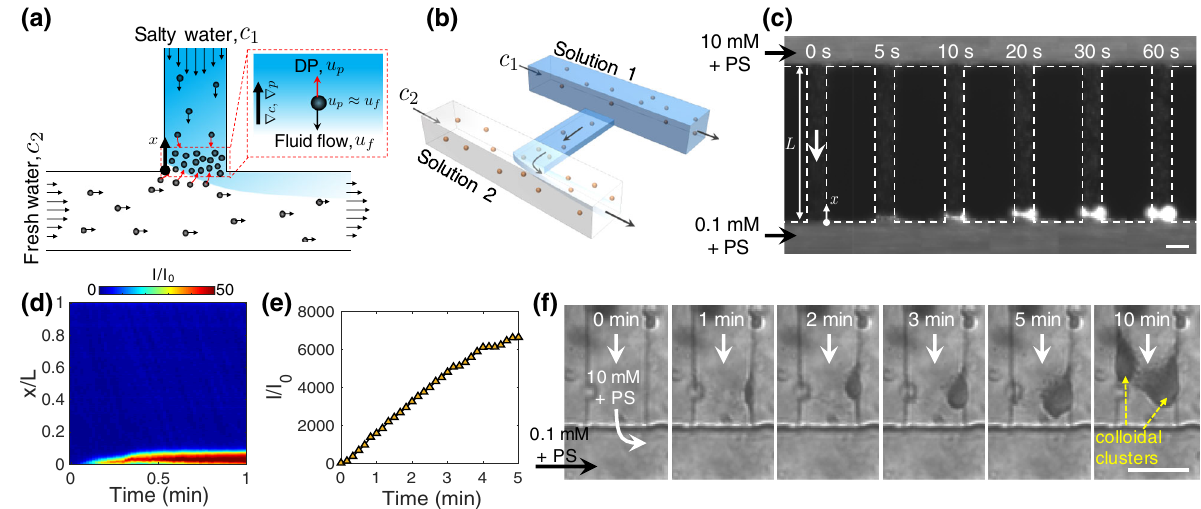
FIG. 1. Mergingof two flow streamswith different soluteconcentrationscan lead to rapidaccumulation of colloidal particles. (a) Particle accumulation near a flow junction due to the balance between diffusiophoretic motion (DP) and the fluid flow. (b) Schematic of the microfluidic channel for testing flow-induced diffusiophoretic particle accumulation. Pressure p in the upper channel (solution 1) is larger than in the lower channel (solution 2), so solution 1 permeates through the pore and merges with solution 2. (c) Fluorescence image sequence of the particles [polystyrene (PS), diameter ¼ 0 . 5 μ m] accumulating near the bottom flow junction (Movie 1 in Ref. [6]). The solute (NaCl) concentration in the upper stream is c 1 ¼ 10 mM, whereas the lower stream has c 2 ¼ 0 . 1 mM. The length of the pore is L ¼ 400 μ m. (d) Spatiotemporal plot of the width-averaged fluorescence intensity within the pore. (e) Evolution of the local maximum fluorescence intensity normalized by the intensity at t ¼ 0 s ( I=I 0 ). (f) Bright-field imaging of the particle accumulation near the flow junction (Movie 2 in Ref. [6]). Densely packed colloidal clusters are clearly seen after 1 minute of the experiment. All scale bars are 50 μ